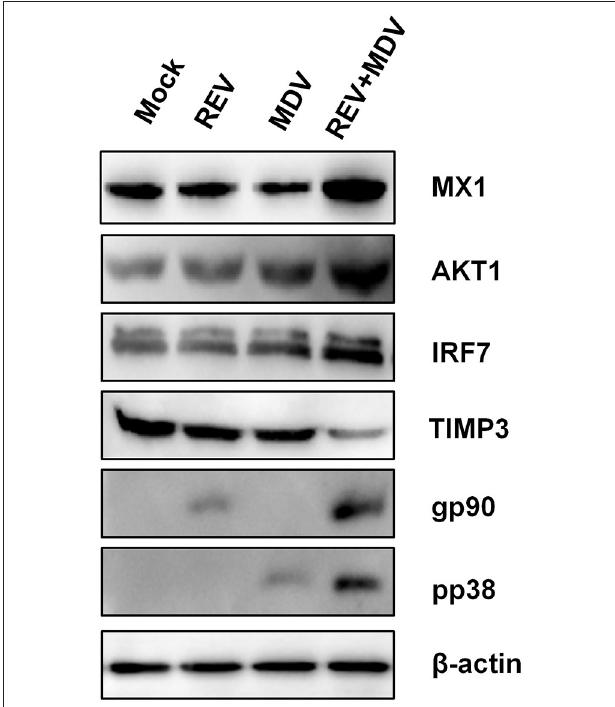
FIGURE 7 | Confirmation of four differentially expressed proteins (IRF7, MX1, AKT1, and TIMP3) in MDV and REV coinfected and single infected, and mock-infected CEF cells by Western blotting. β -Actin was used as an internal control to normalize the quantitative data. MDV, Marek’s disease virus; REV, reticuloendotheliosis virus; CEF, chicken embryo fibroblast.